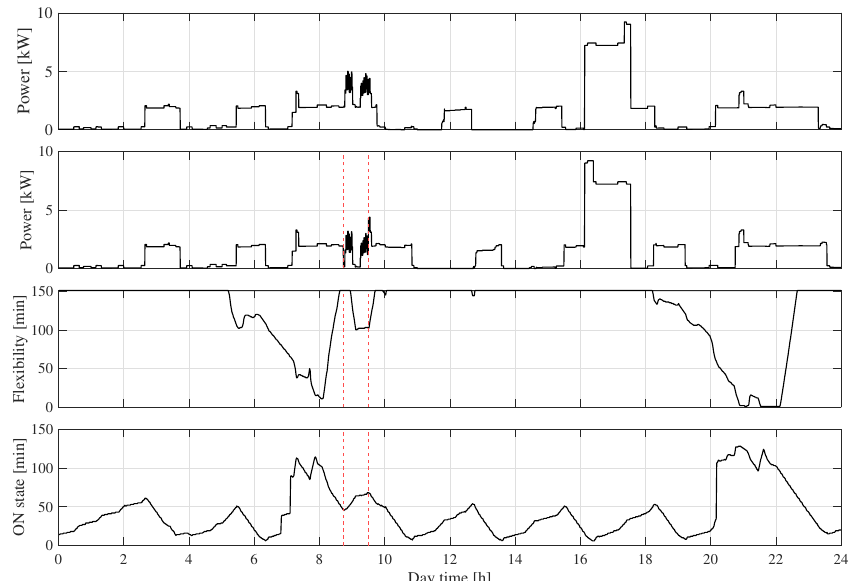
Figure 12. Consumption profile for the use-case scenario without ( top ) and with flexibility event ( second from top ) offering the heat pump flexibility with the calculated duration event duration. The possible flexibility event duration ( second from bottom ) and the time until the upper operation temperature θ strg,max when in ON state is reached ( bottom ) with the flexibility event marked by a red-dotted